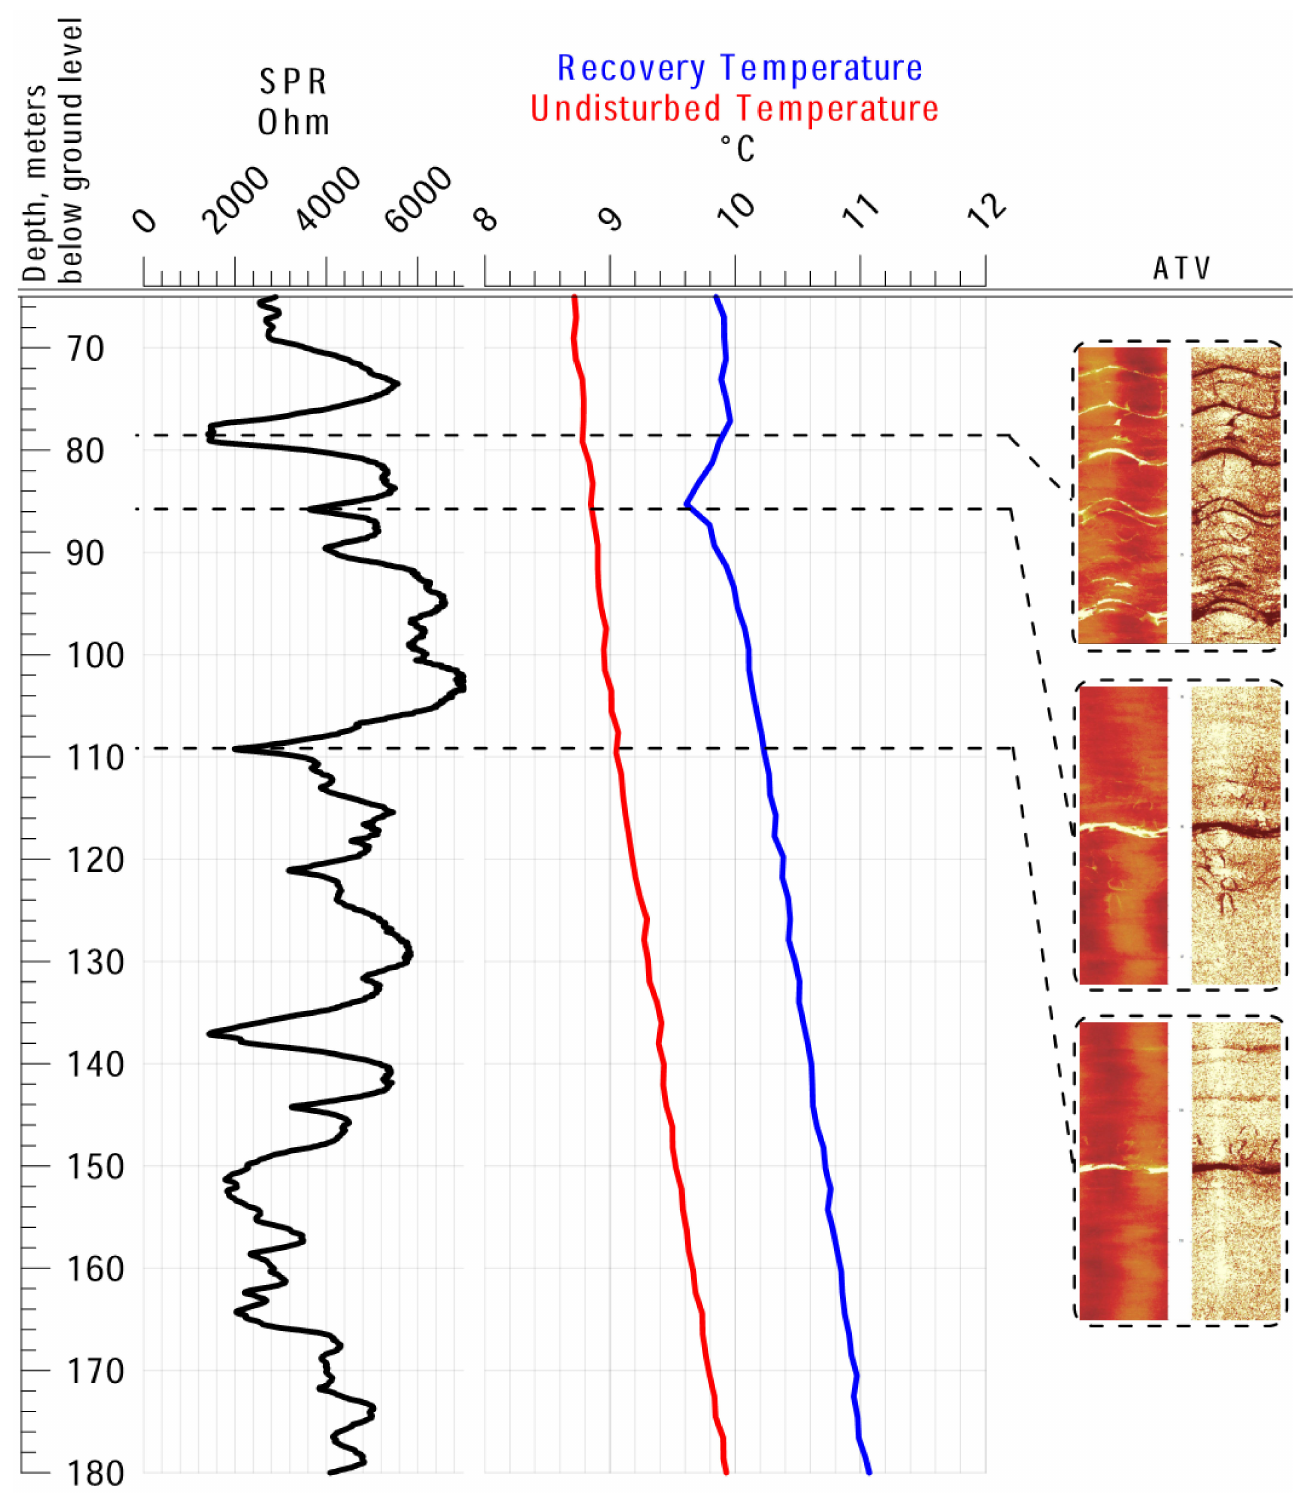
Figure 11. Detection of flowing fractures using single point resistance (SPR) logs and temperature profiles acquired during DTRT in the 240 m deep Distorp Hagen